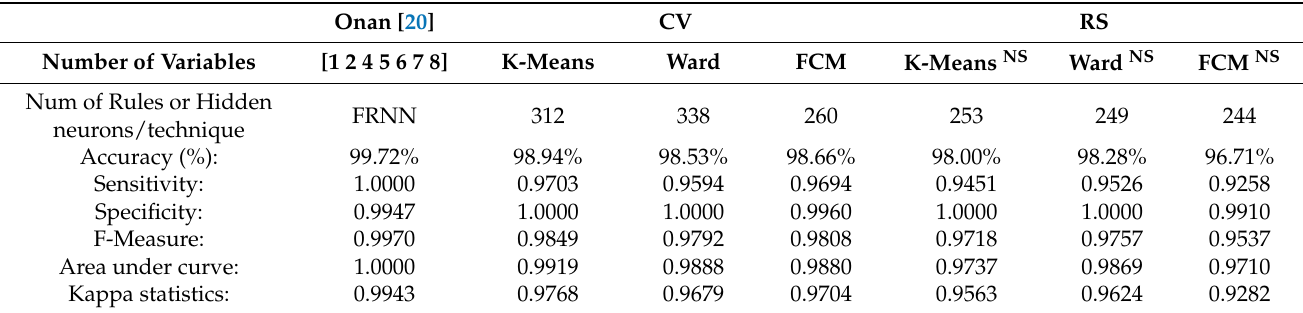
Table 3. Performance metrics obtained with our proposed framework compared with results obtained by [20]. Onan